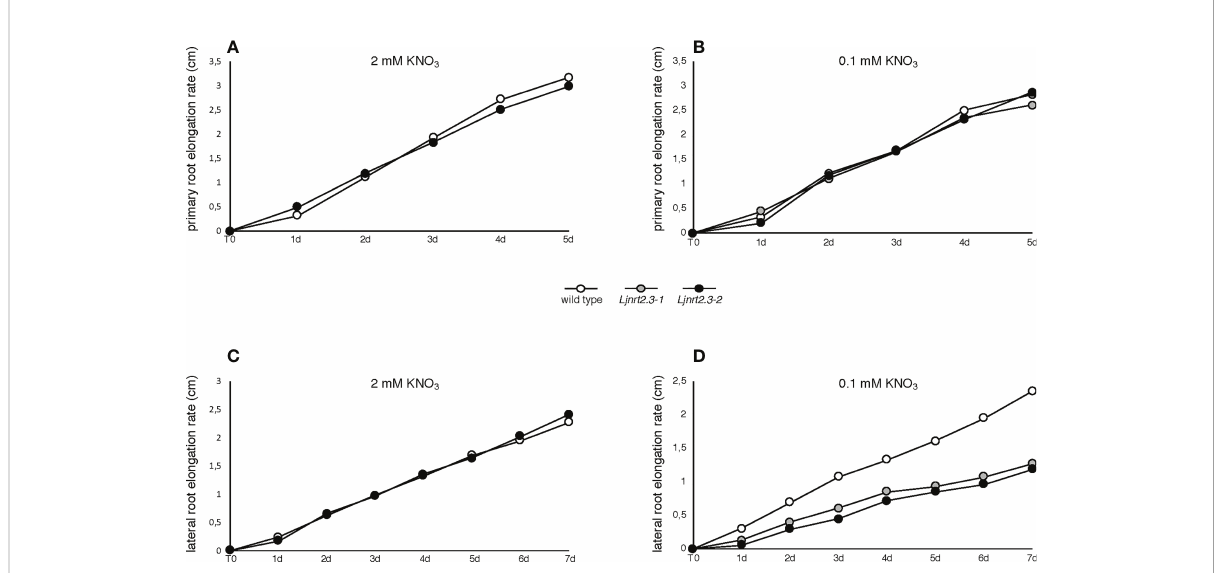
FIGURE 6 Root elongation rates in wild type and Ljnrt2.3 plants. (A, B) elongation rate of primary roots of wild type and Ljnrt2.3-1 plants. (C, D) elongation rate of lateral roots of wild type, Ljnrt2.3-1 and Ljnrt2.3-2 plants. Synchronized seedlings were grown for 8 days on B5 derived medium supplemented with 8 mM KNO 3 as sole N source and then transferred under N starvation conditions for 6 days. Then plants were transferred on 0.1 mM and 2 mM KNO 3 (T0) and measures of primary and lateral roots taken every day. The scoring was carried out on lateral roots long at least 0,3 cm at the time of the transfer. The KNO 3 concentrations and plant genotypes are indicated. Wild type and Ljnrt2.3 plants were grown in the same square Petri dishes to minimize the differences of growth conditions. Data represent means of measures performed in two/three